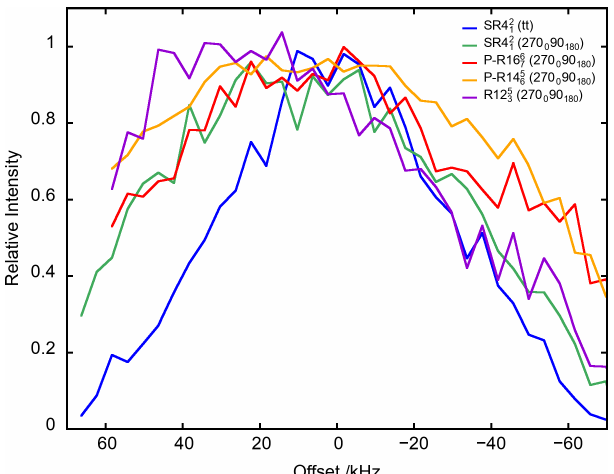
Figure 8. The 27 AlO 6 signal of γ -alumina at ν R = 62 . 5kHz as a function of offset for PRESTO-R16 6 R14 5 (270 0 90 180 ) as well as RINEPT-CWc-SR4 2 6 SR4 2 (270 0 90 180 ) and RINEPT-R12 5 1 τ and ν 1 or ν 1 , max were fixed to their optimum values given in Ta- ble